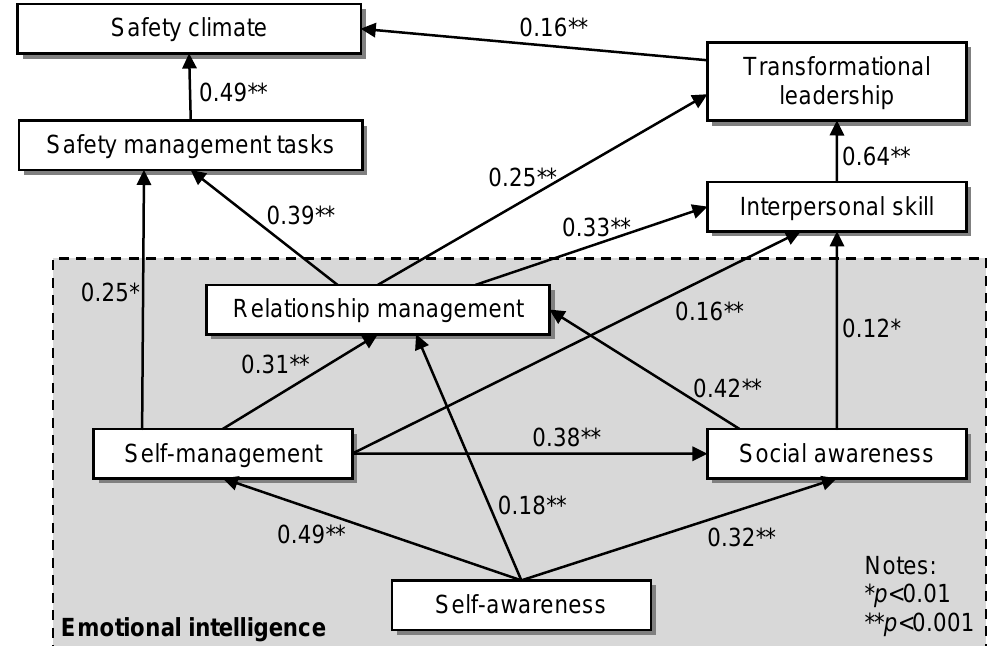
Figure 2 Best-fit model of the SEM analysis